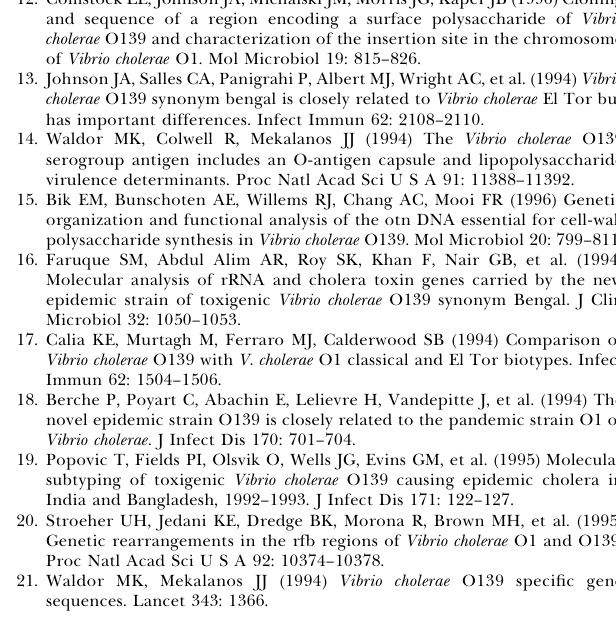
Figure S4. PCR and CGH Analysis of Donor and Transformant gDNA Show Exchange of O-Antigen–Encoding Gene Clusters